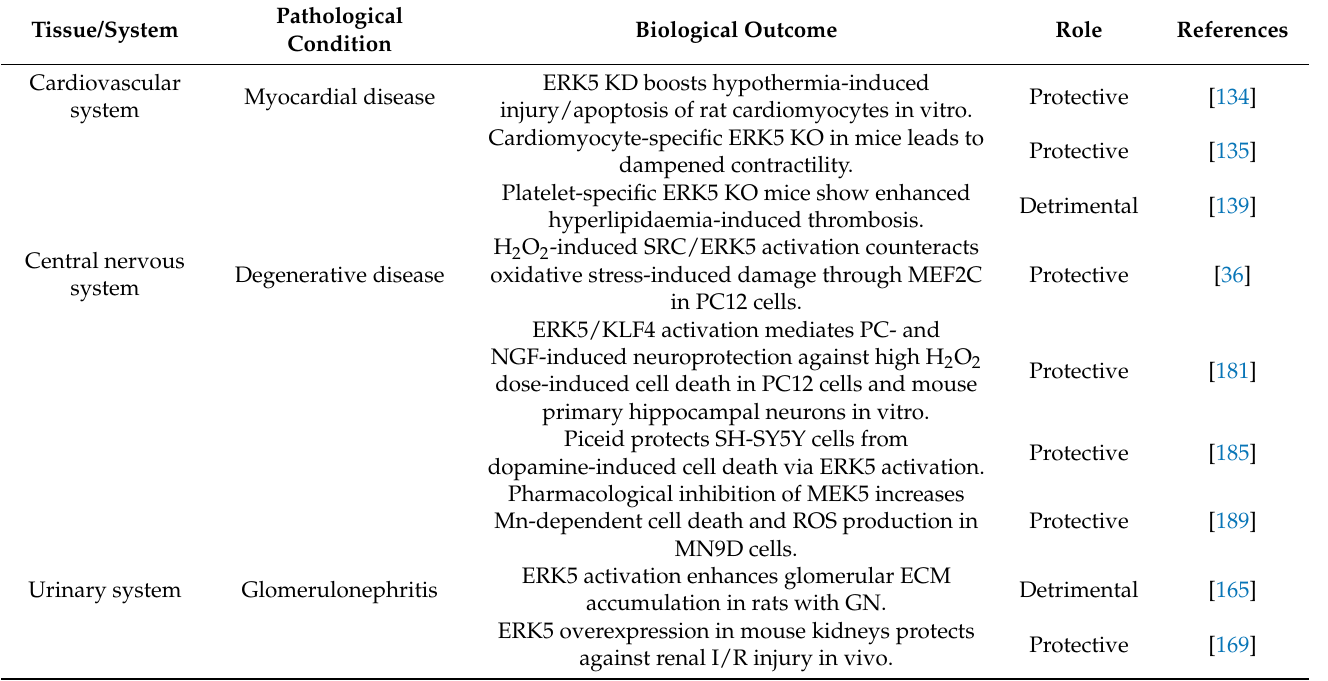
Table 1. Role of the ERK5 pathway in response to oxidative stress in pathological